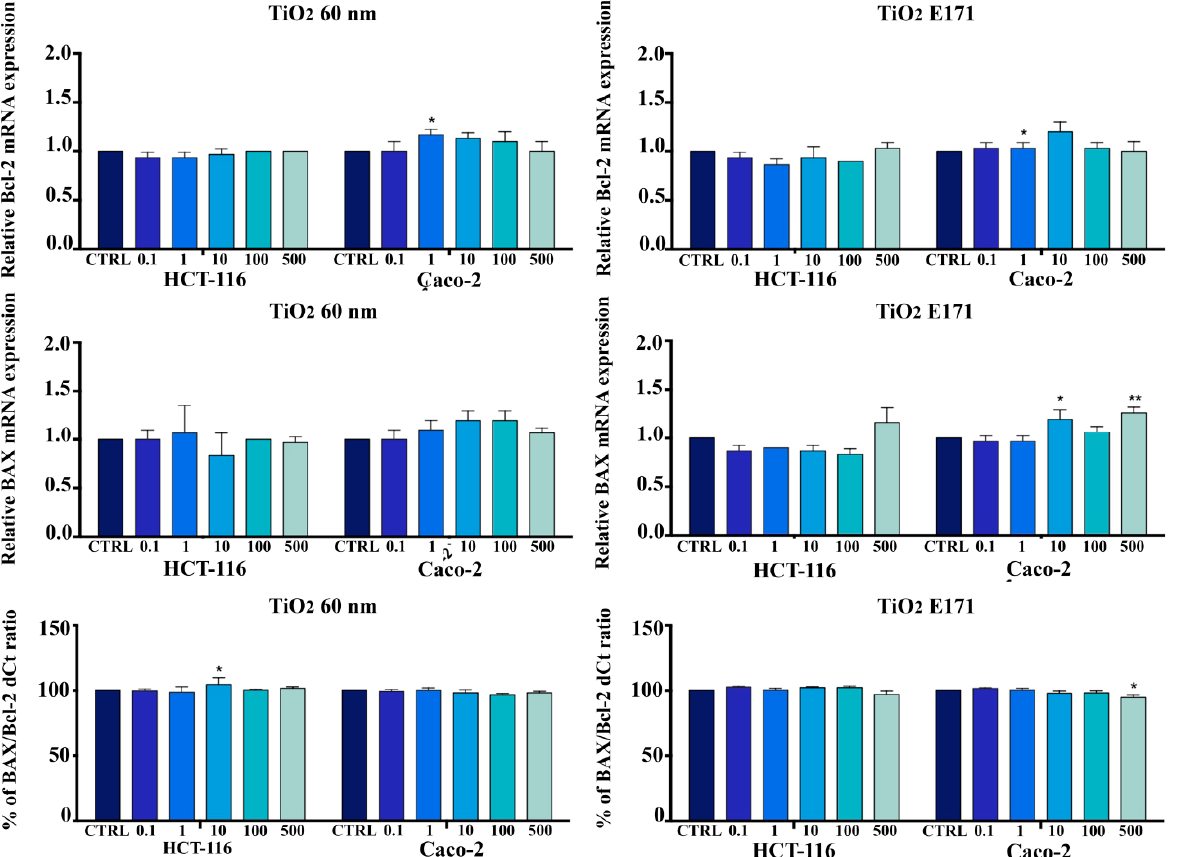
Figure 3. Bcl-2 and BAX mRNA expression: untreated vs. treated (72 h). Relative gene expression (mean fold change) of Bcl-2 and BAX in TiO 2 -treated versus non-treated HCT-116 and Caco-2 cells. Both cell lines were cultured with increasing doses of TiO 2 (0; 0.1; 1; 10; 100; 500 mg/L) for 72 h, and then RT-PCR was carried out with specific primers. For analysis, GAPDH was used as the internal reference, and non-treated cells were used as the calibrator. mRNA relative expression for all genes was calculated by the comparative quantification Ct method ( ΔΔ Ct). Results are representative of three independent experiments. * p < 0.05 vs. control; ** p < 0.01 vs. control.